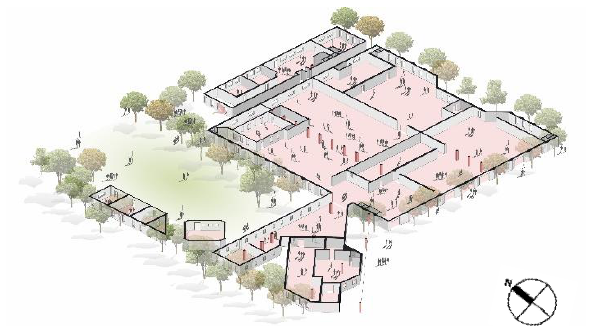
Figure 7 . Design hypothesis ground floor - Ex Alma area